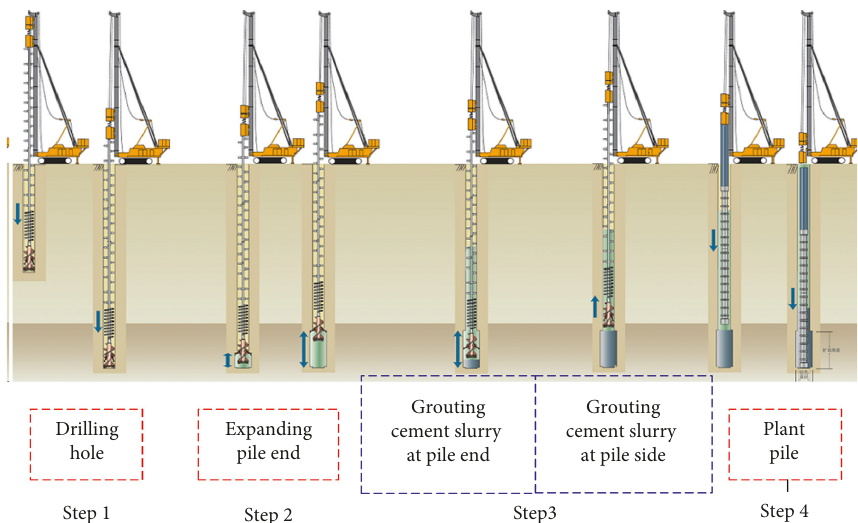
Figure 1: Construction process of static drill rooted pile.